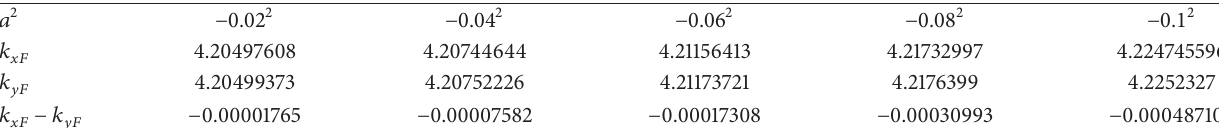
Table 2: Fermi momentums 𝑘 𝑥𝐹 and 𝑘 𝑦𝐹 with samples 𝑎 2 for 𝑎 2 < 0 .